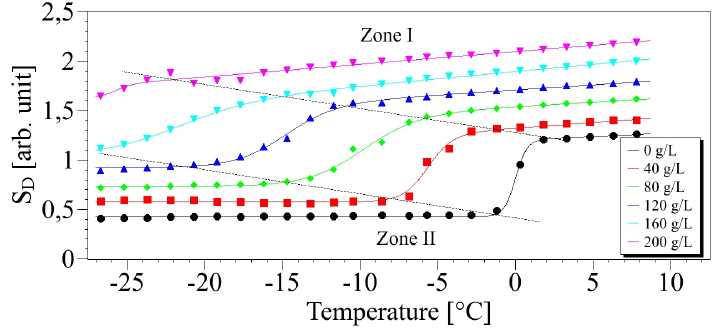
Figure 5. Points: concentration index S concentration. Lines: fit with Equation 2.